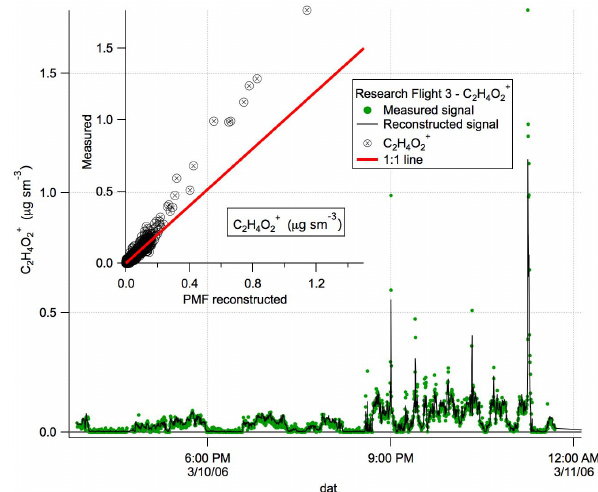
Fig. 11. This figure shows the timeseries of the measured and the PMF modeled signal for C 2 H 4 O + vs. PMF modeled signal for C 2 H 4 O +